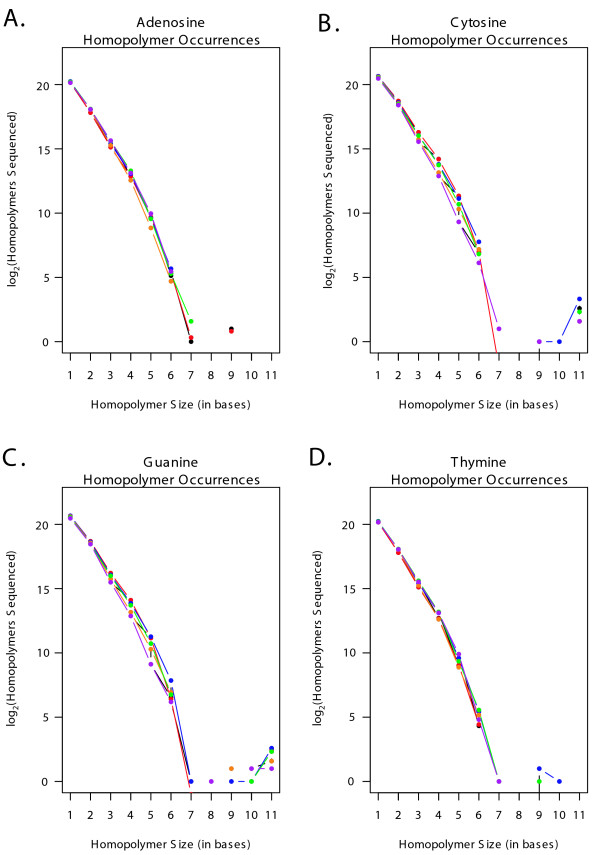
A – D: Hompolymer coverage in Halobacterium sequence reads. A. A log2plot illustrating the total number of adenosine homopolymers sequenced in reads generated by control and amplified populations of Halobacterium species NRC-1 DNA. The data from the unamplified replicate population are shown in red, GenomiPhi in blue, Repli-G in orange, PEP in green and DOP in purple. B. As Figure 1A., but for Cytosine homopolymers. C. As Figure 1A., but for Guanine homopolymers. D. As Figure 1A., but for Thymine homopolymers.